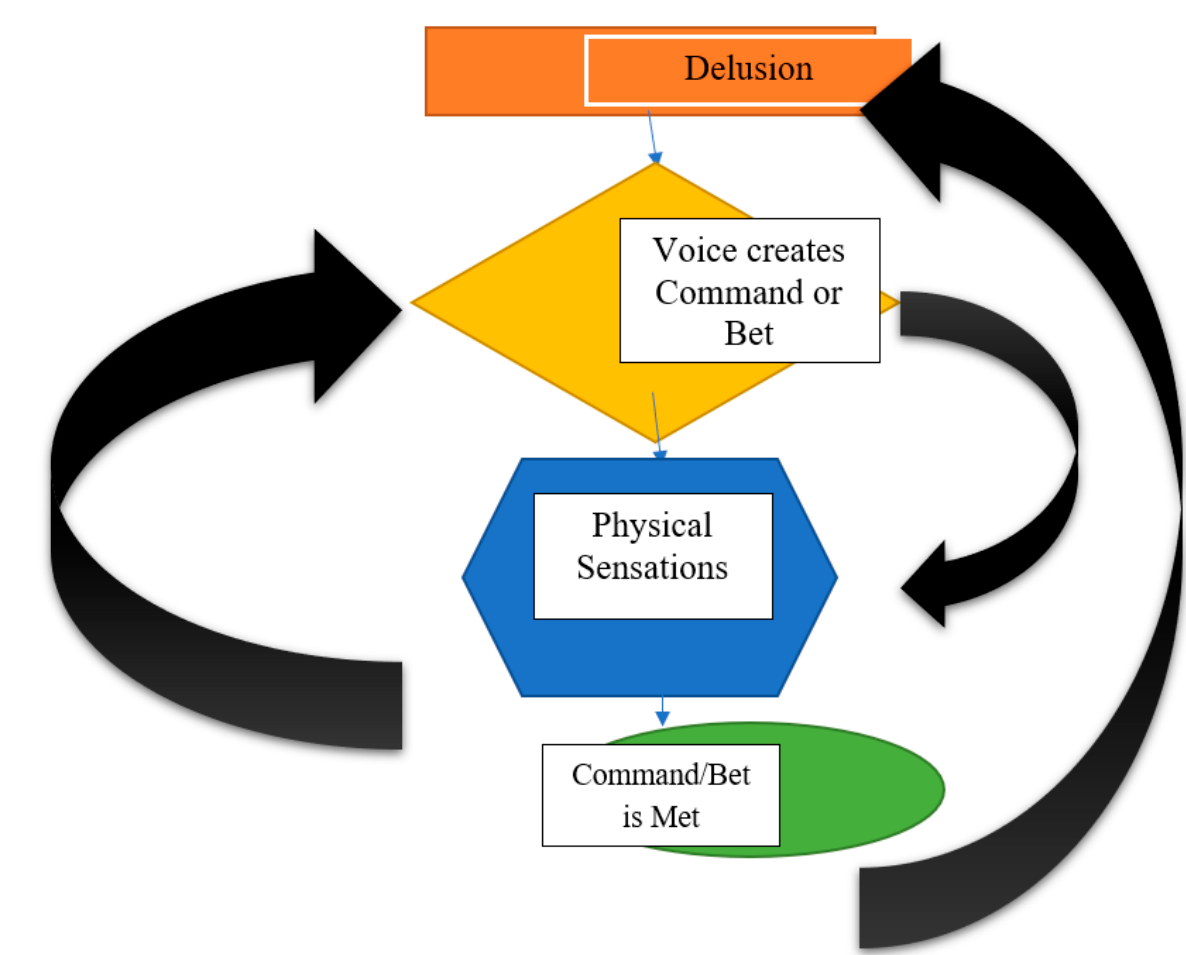
Figure 2. Acute Psychosis Feedback Loop.